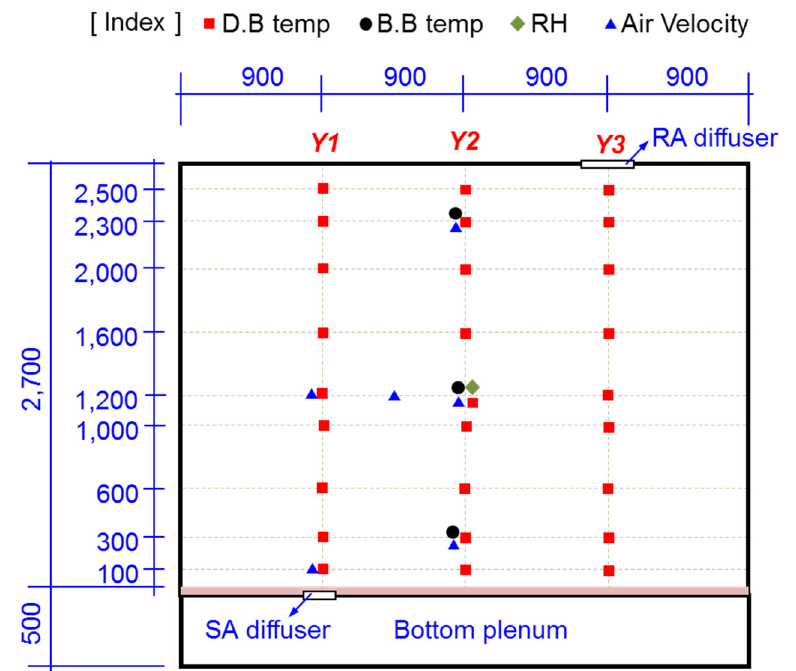
Figure 12. Location of measuring points (section) (unit: